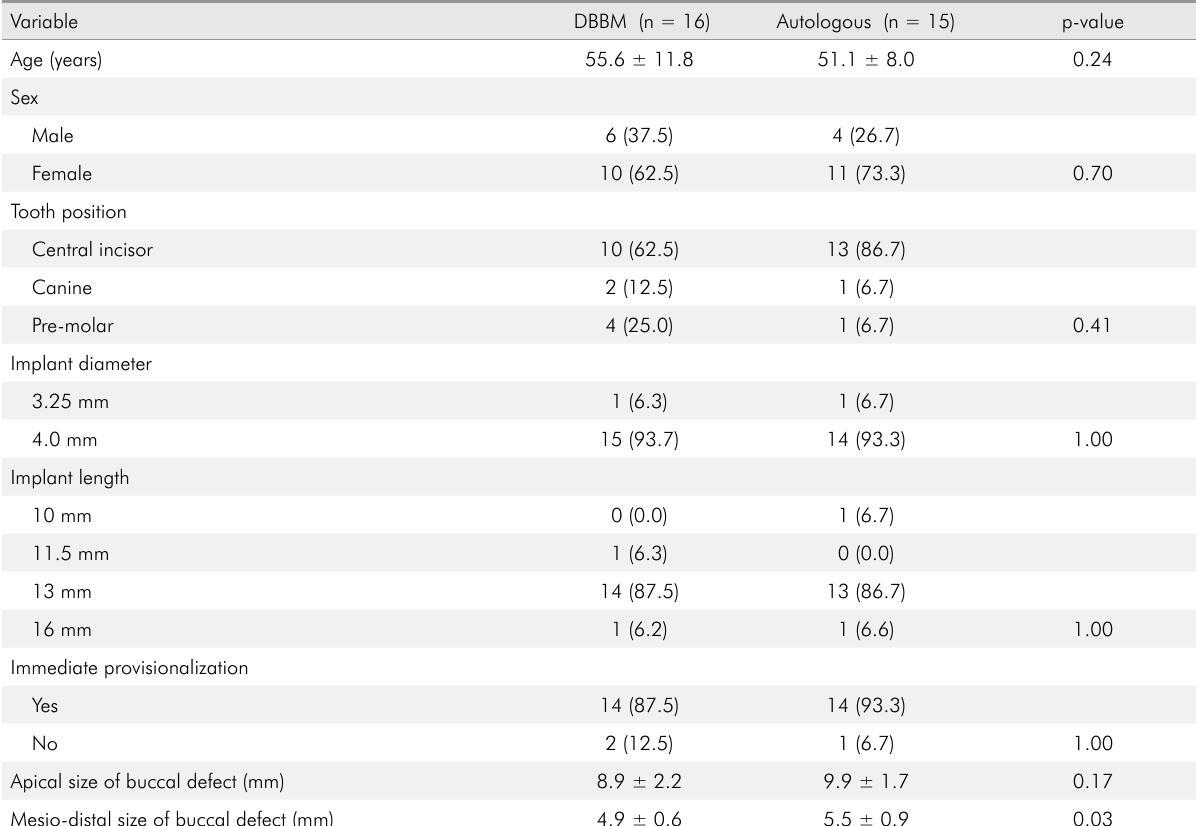
Table 1. Patients’ characteristics in autologous and bovine bone